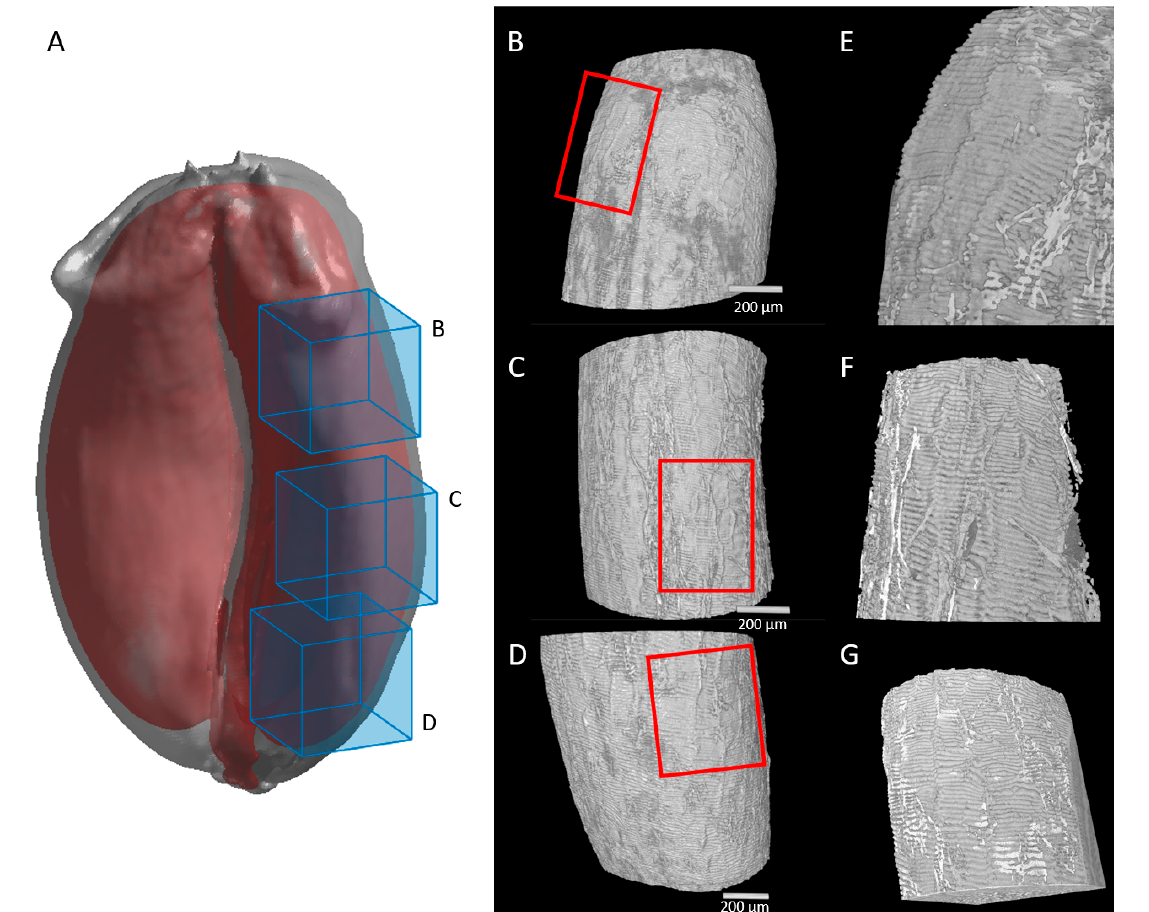
Figure 10. Morphology of cross cells at the surface of a caryopsis endocarp at 250 °DAA. ( A ) Localization of observed regions. Gray surface corresponds to the caryopsis outer surface, red surface corresponds to endocarp. ( B – D ) Reconstruction of endocarp surface showing cross cells at top ( B ), middle ( C ), and bottom ( D ) regions. ( E – G ) Zoom on the cross cells of the caryopsis in regions depicted by the red frames, highlighting the organization in